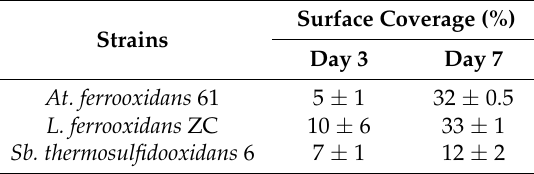
Table 3. Pyrite surface coverage by biofilm cells of At. ferrooxidans 61, L. ferrooxidans ZC or Sb. thermosulfidooxidans 6 determined by ImageJ (v1.52g)